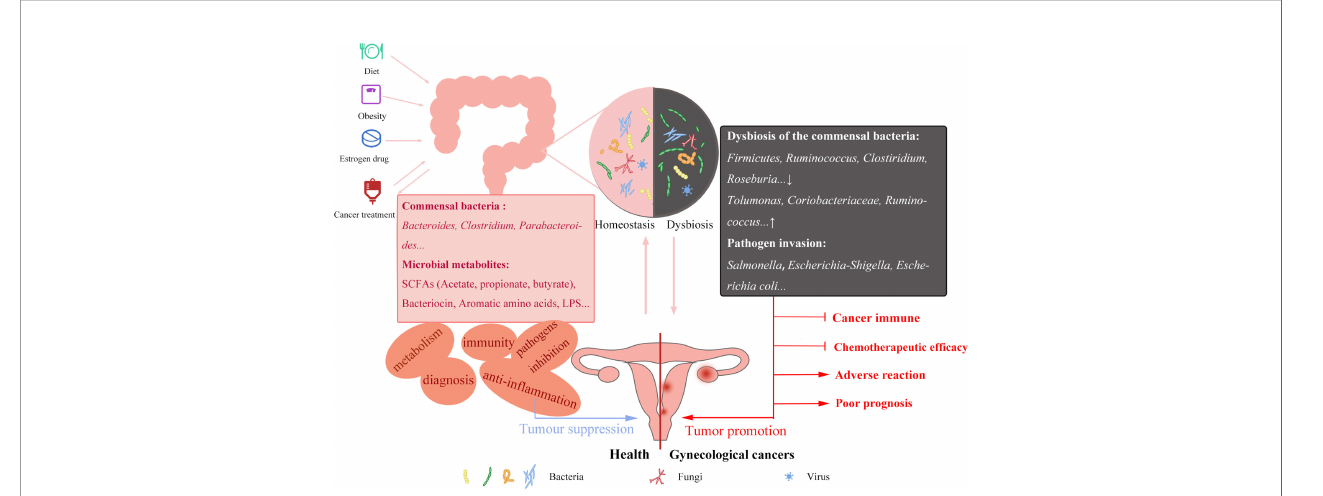
FIGURE 1 | Factors affecting GM and its potential mechanisms of GM in gynecological cancers. Unhealthy diet, obesity, estrogen drug abuse and cancer treatment can affect the homeostasis of GM, commensal bacteria decreased and pathogenic bacteria increased. Interaction between GM and gynecological cancers. GM stabilization can inhibit the occurrence of cancer in immunity and preventing pathogen invasion. The reduced protective effect of the maladjusted GM will also play an adverse role in cancer immunity, chemotherapy ef fi cacy and prognosis. In-depth study of GM changes in gynecological cancer patients can be applied to the screening, improve the treatment of gynecological cancers and improve the poor